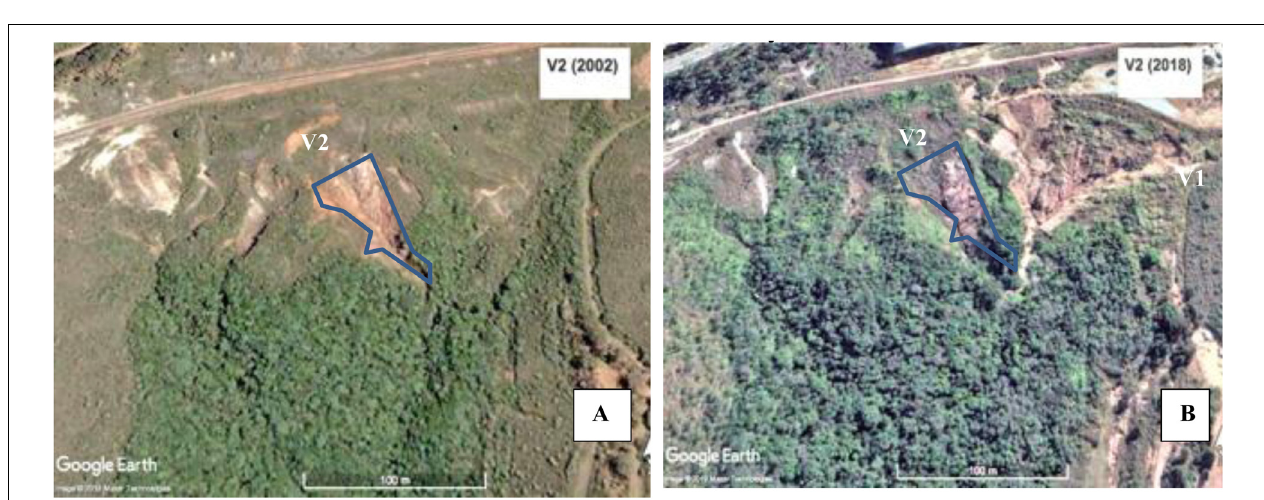
FIGURE 10 | Satellite image history indicating the emergence of incision V1-b. Yellow arrows represent V1-b and green arrows a V1-a. (A) Presence of ravines in the abandoned road in 2013. (B) Recovery of the abandoned road in rehabilitation works of “Jardim da Torre” neighborhood in 2014. (C) Appearance of incision V1-b in 2015. (D) Intensification of the erosive process in 2019. Source: Adapted from Google Earth, 2002–2019.